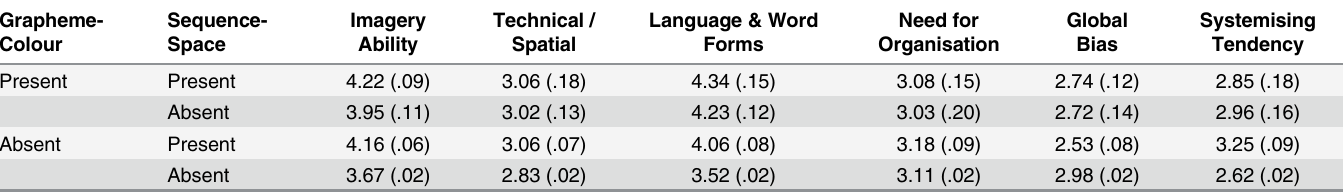
Table 6. Mean factor scores as a function of presence/absence of grapheme-colour and sequence-space synaesthesia. Grapheme- Sequence- Colour